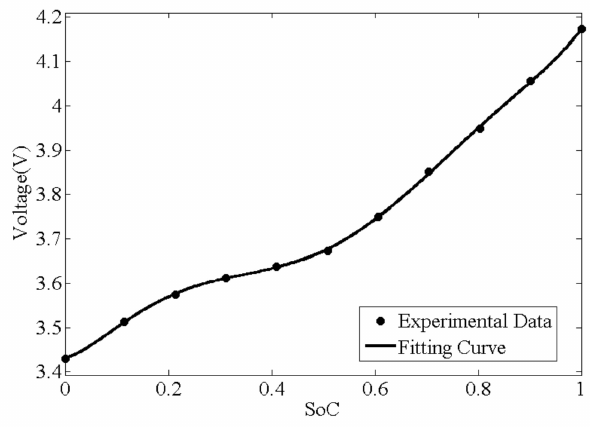
Figure 8. u oc -State-Of-Charge (SoC) fitting curve. Table 2. Identification results of the fitting curve.